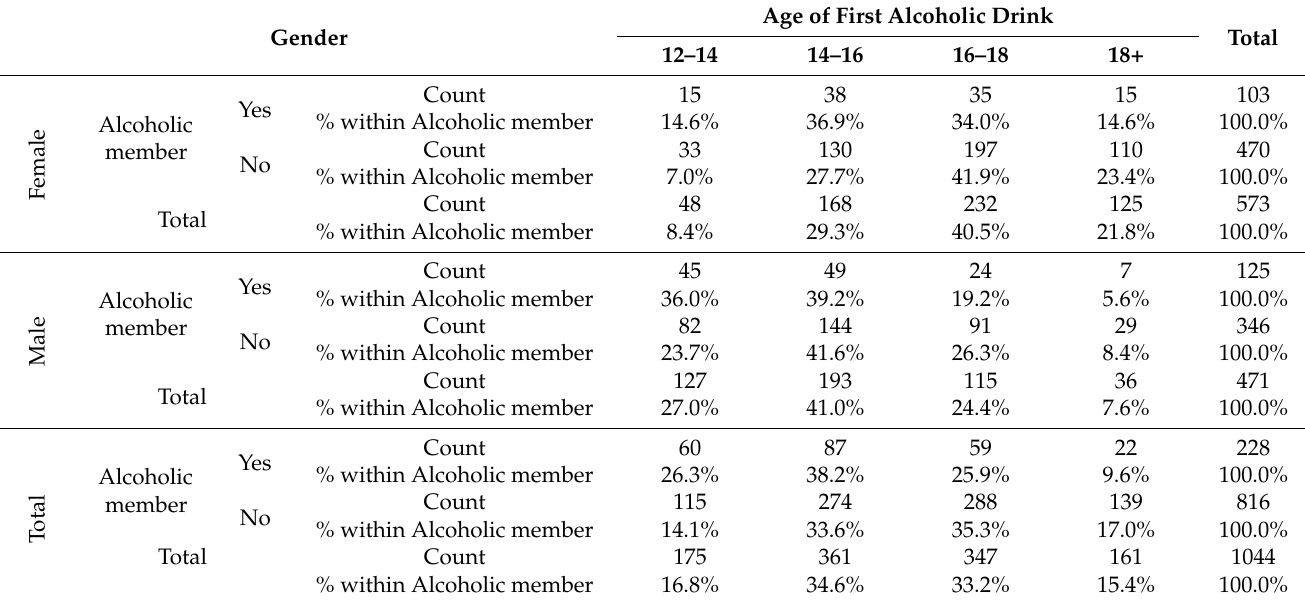
Table 3. The interaction between gender, age of first drink and alcoholic